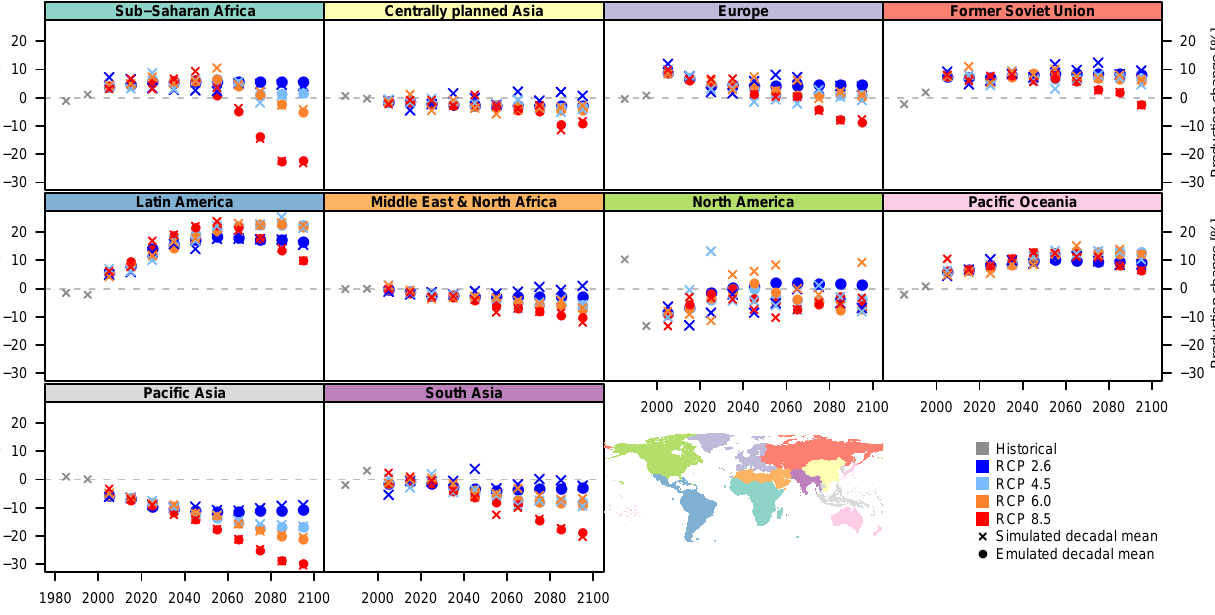
Figure 10. Comparison of simulated and emulated time series of regionally aggregated crop production changes for LPJmL forced by HadGEM2-ES climate projections. Results are shown for maize and emulator approach (c). Analogous figures for the other crops, emulator approaches, and GGCMs are available in the